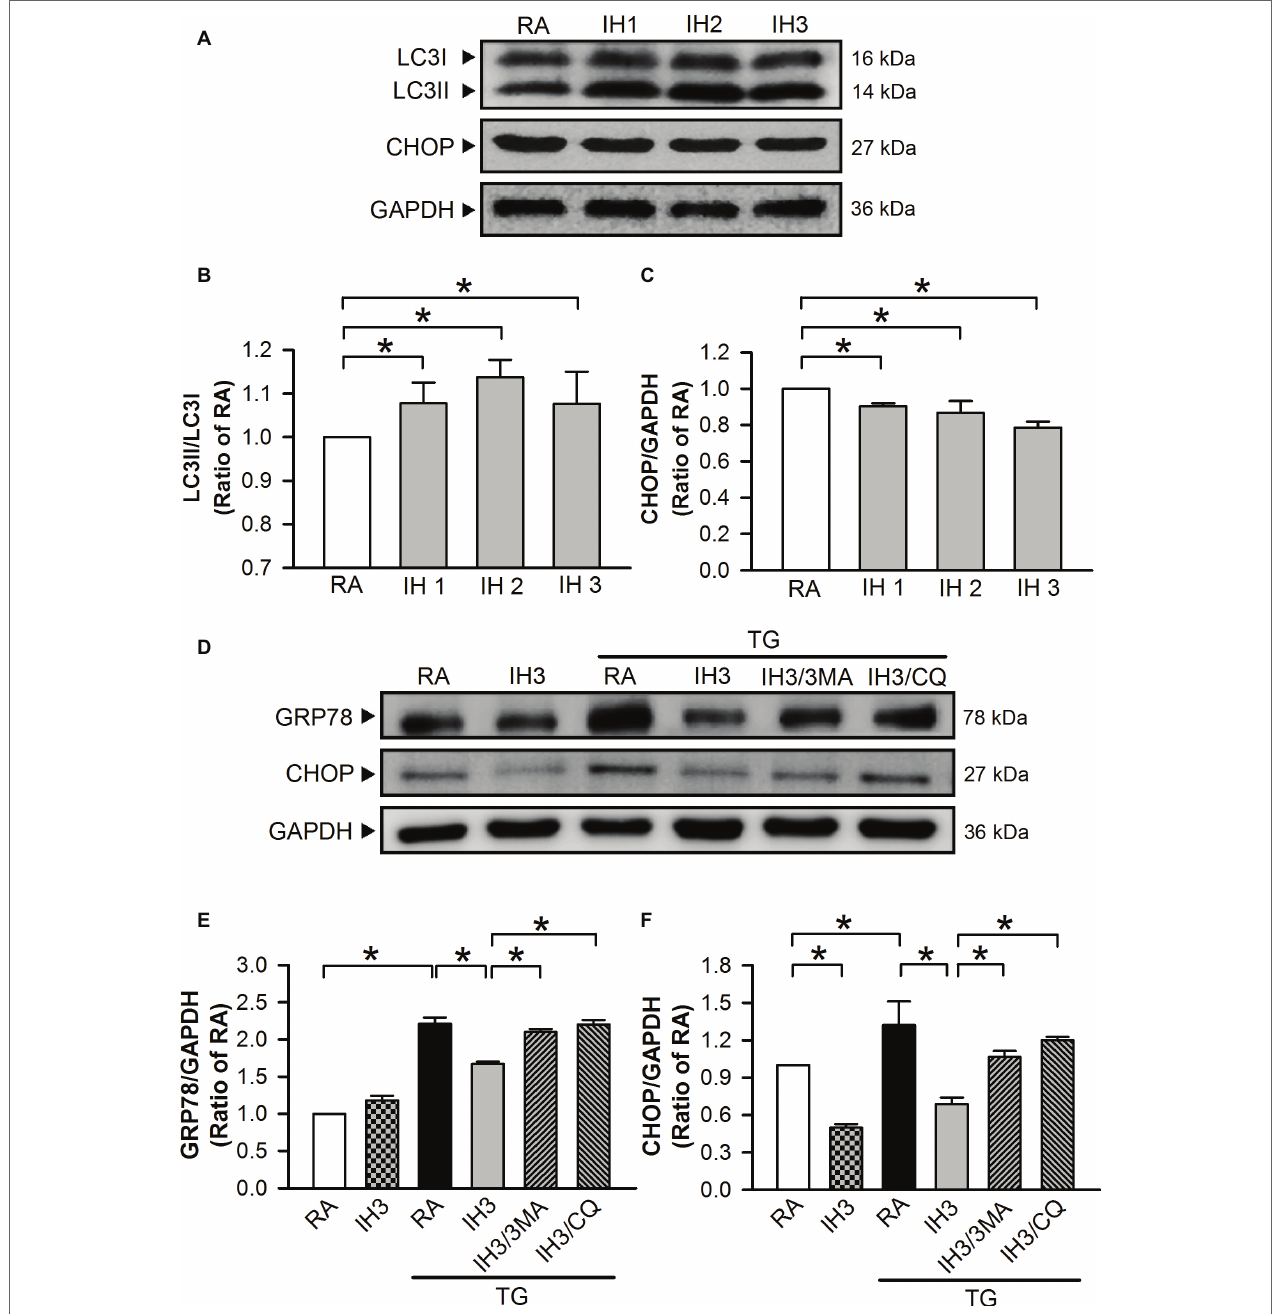
FIGURE 8 | Involvement of autophagy in the IH-attenuated myocardial ER stress in vivo . C57BL/6 mice were exposed to RA or IH for 1, 2, or 3 days, or IH 3 days followed by thapsigargin (15 mg/kg/day), thapsigargin combined with 3-methyladenine (15 mg/kg/day), or thapsigargin combined with chloroquine (mg/kg/day), and then sacrificed for detecting the myocardial LC3, CHOP, GRP78, and GAPDH protein levels. (A) A representative result of LC3I, LC3II, CHOP, and GAPDH protein levels determined by Western blot analyses. Quantitative results of the protein levels of LC3II/LC3I (B) and CHOP/GAPDH (C) were expressed as ratio over the RA group. Values are means ± SEMs. ( n = 3). (D) A representative result of GRP78, CHOP, and GAPDH protein levels determined by Western blot analyses. Quantitative results shown in (E) for the GRP78 protein levels and (F) for CHOP protein levels were adjusted with GAPDH protein level and expressed as ratio over the RA control group. Values are means ± SEMs. ( n = 4). * p < 0.05. MA, 3-methyladenine; CQ, chloroquine; IH, intermittent hypoxia; RA, room air; TG,